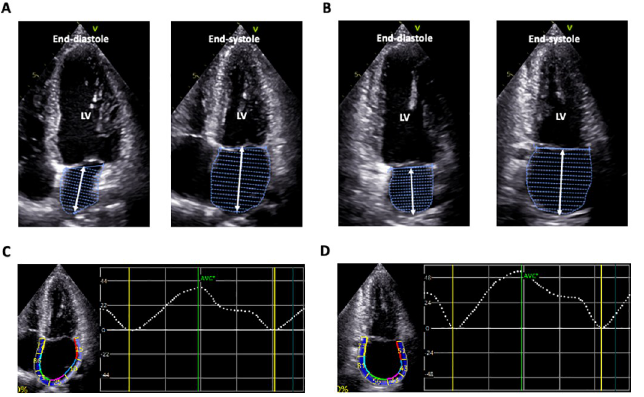
Fig 1. How to measure left atrial volume, length, and strain using 2D echocardiography. A and B: left atrial endocardial border tracking on the apical four-chamber (A) and two-chamber (B) views from which disk-area and length were determined. C and D: Corresponding left atrial strain